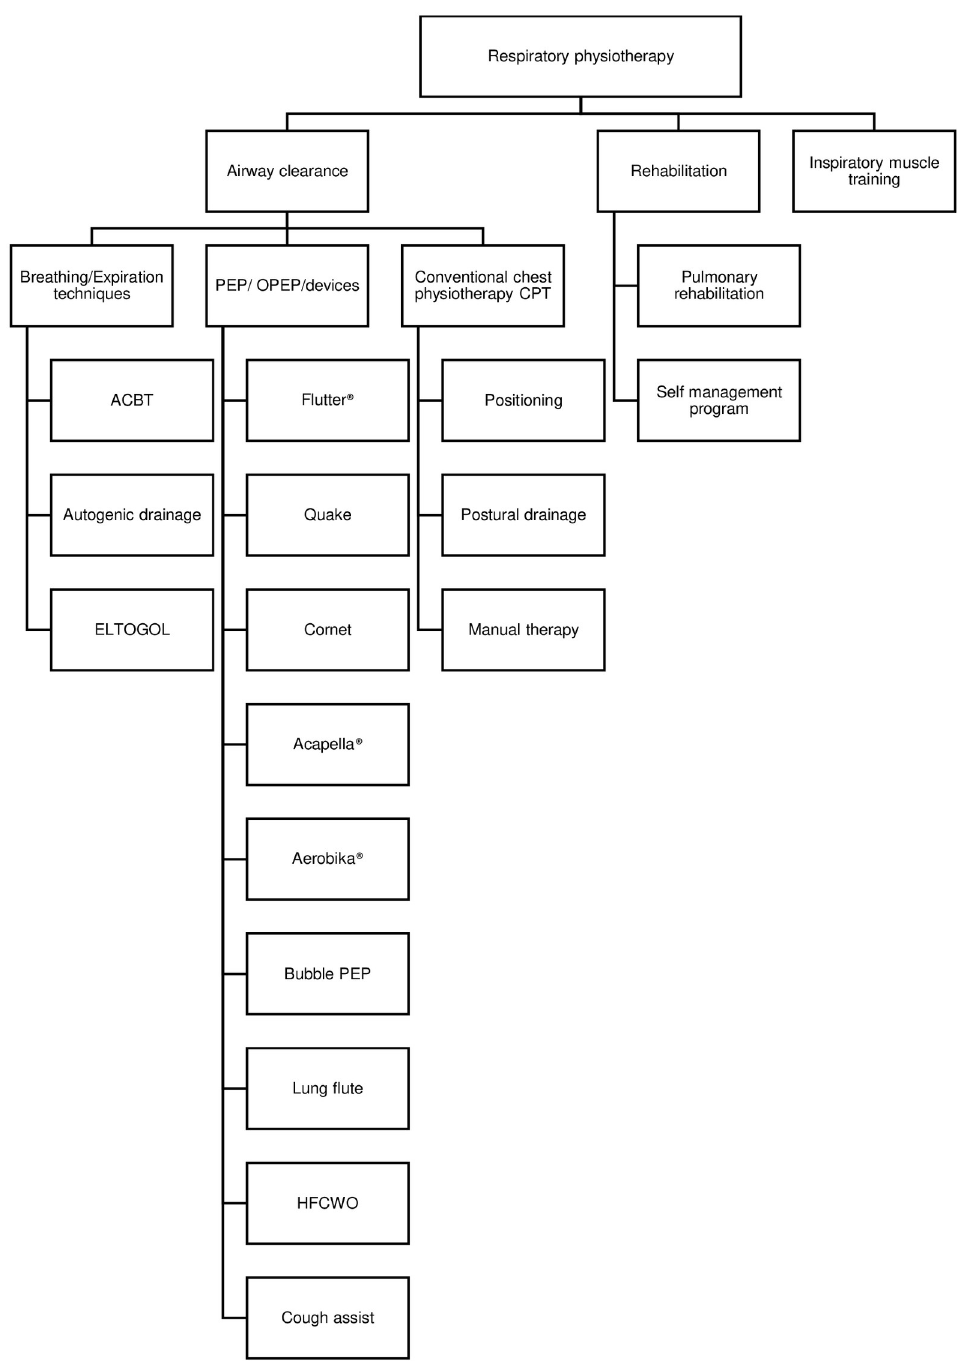
Fig 1. Flow of studies through the review, PRISMA 2020 flow diagram [31]. ACBT: active cycle breathing technique, CPT: chest physiotherapy, PEP: positive expiratory pressure, OPEP: oscillating positive expiratory pressure IMT: inspiratory muscle training, ELTGOL: slow expiration with the glottis opened in a lateral posture, HFWCO: high frequency chest wall oscillation.